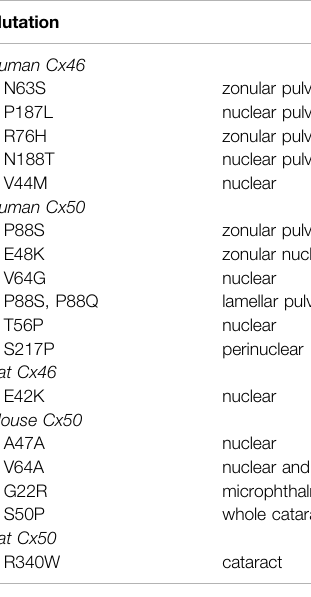
TABLE 1 | Summary of Cx46 and Cx50 mutants associated with cataract